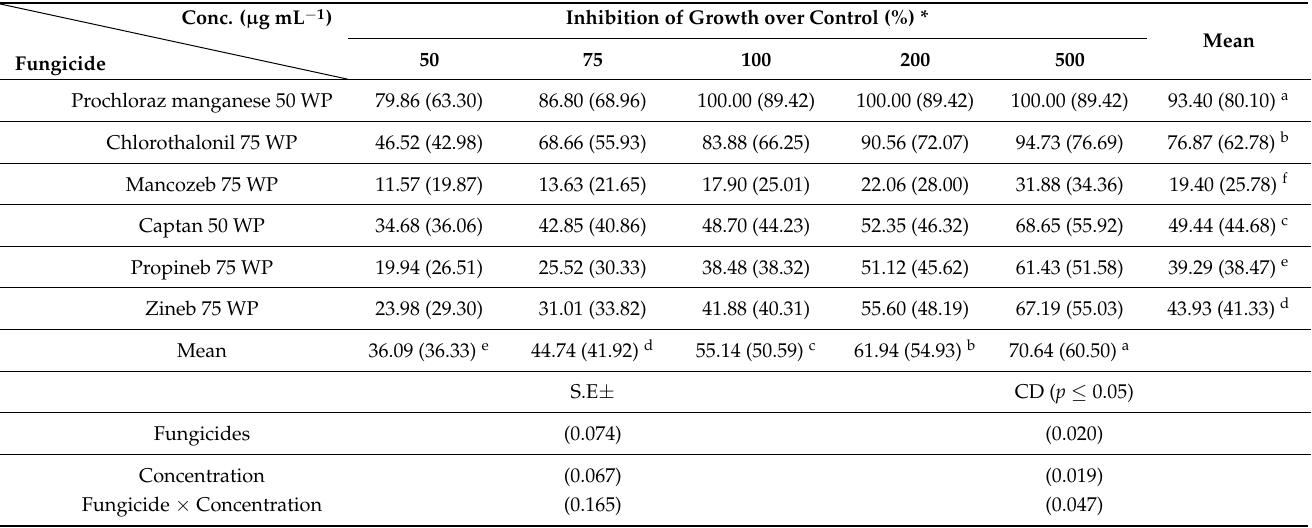
Table 2. Effect of non-systemic fungitoxicants under in vitro conditions against T. harzianum mycelium.